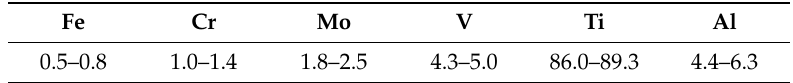
Table 1. Chemical composition (in %) of titanium alloys VT23 and VT23M.